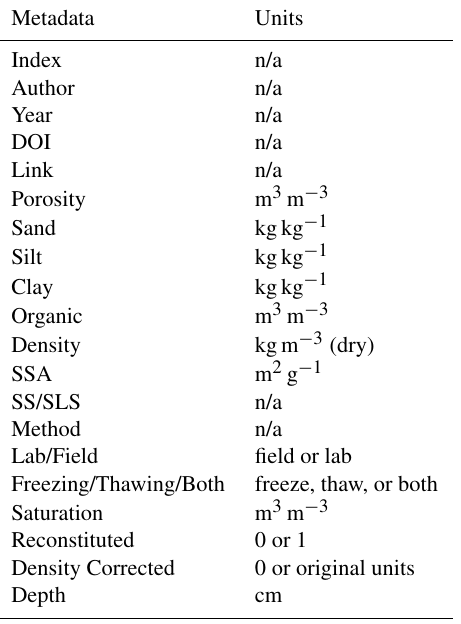
Table B2. SFCC metadata template. Note that if data are not avail- able, fields should be left empty. n/a – not